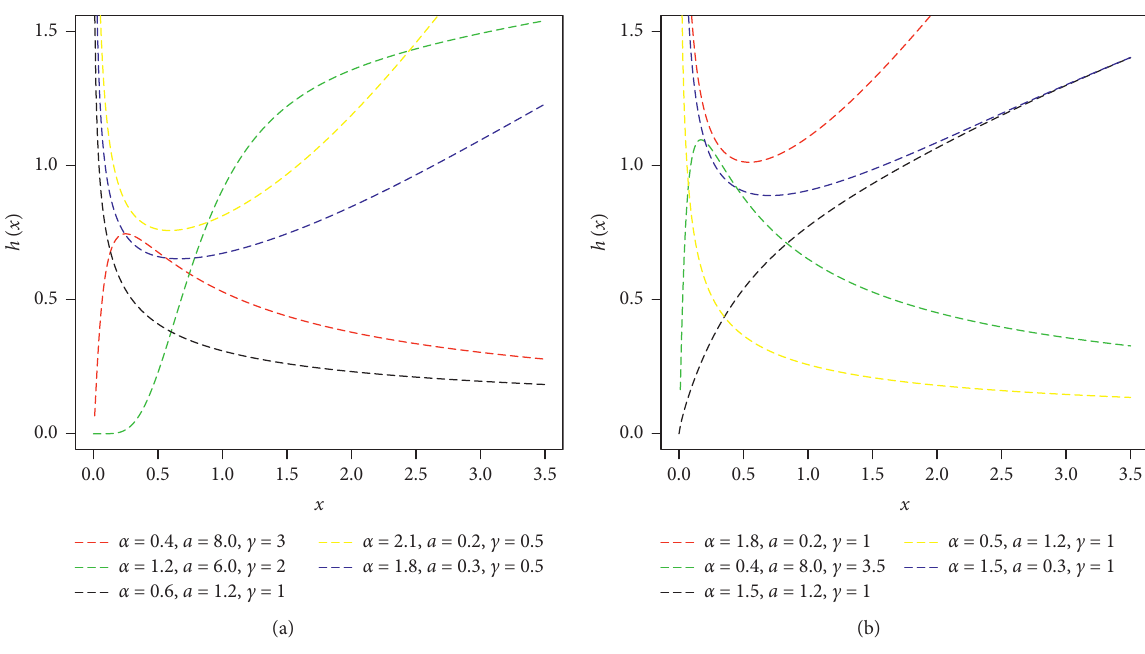
Figure 2: Different plots for the hrf of the ASE-W distribution for selected values of its